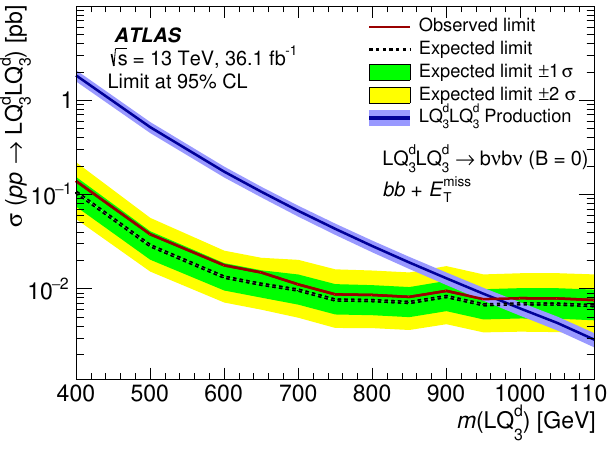
Figure 16 . Observed and expected 95% CL upper limits on the cross-section for down-type LQ pair production with B = 0 as a function of the LQ mass. The (cid:6) 1(2) (cid:27) uncertainty bands around the expected limit represent all sources of statistical and systematic uncertainties. The thickness of the theory curve represents the theoretical uncertainty from PDFs, renormalization and factorization scales, and the strong coupling constant (cid:11) s